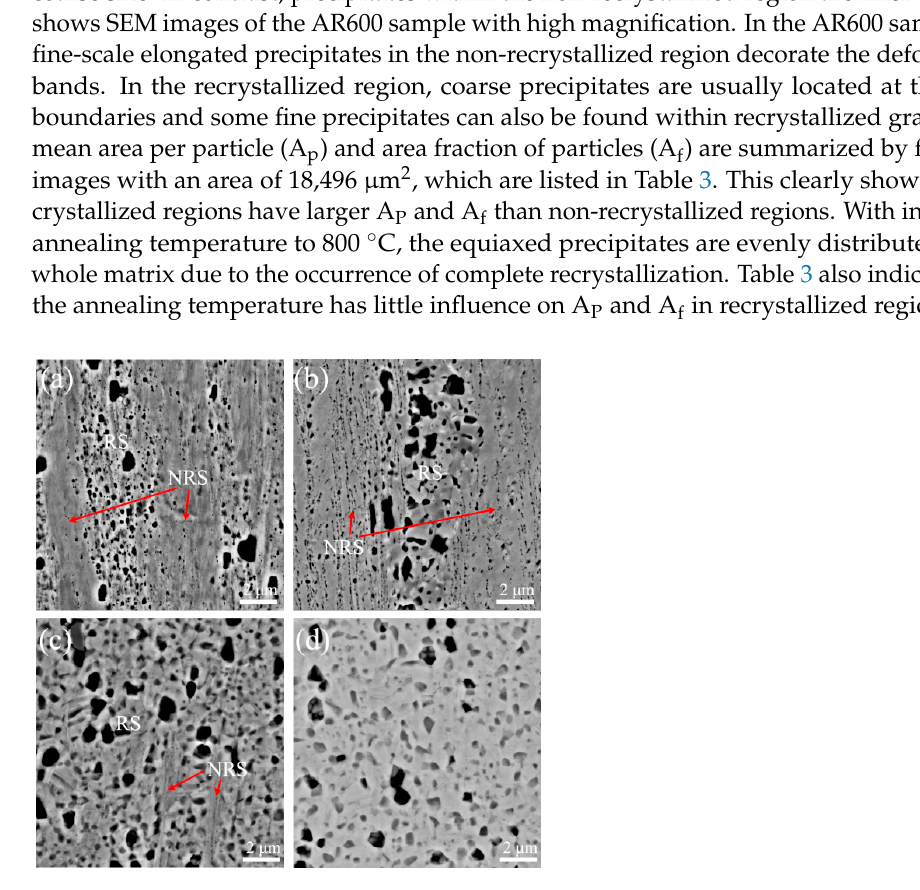
Figure 3. SEM-ECC images of AR sample aged at various temperatures. ( a ) AR590 sample; ( b ) AR660 sample; ( c ) AR700 sample; ( d ) AR800 sample.